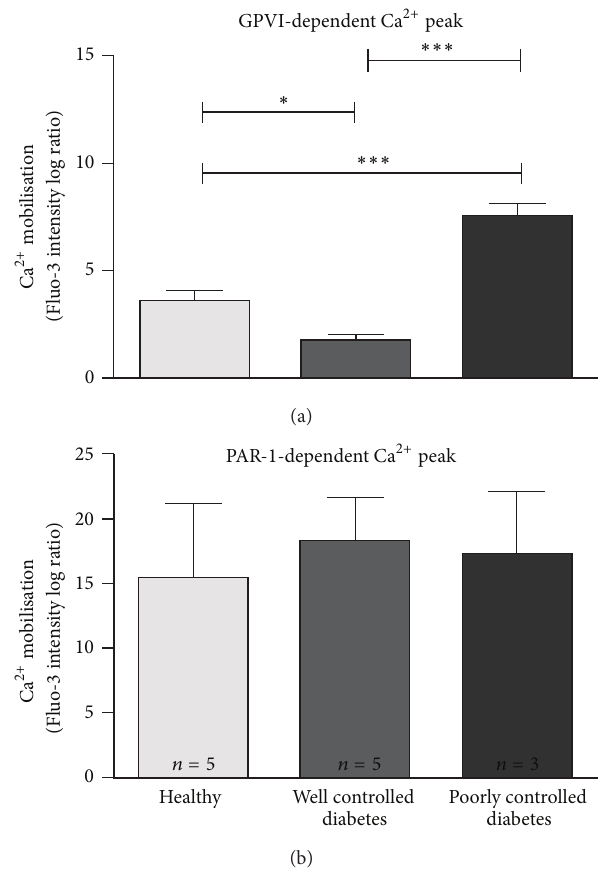
Figure 3: Influence of well- and poorly controlled diabetes on intracellular calcium mobilisation. Flow cytometry of Fluo-3-AM- loaded monkey platelets in PRP treated with 10 𝜇 g/mL CRP (a) or 10 𝜇 M TRAP (b). Data are from three to five monkeys in each group. ∗ 𝑃 < 0.05 , ∗∗∗ 𝑃 < 0.001 .